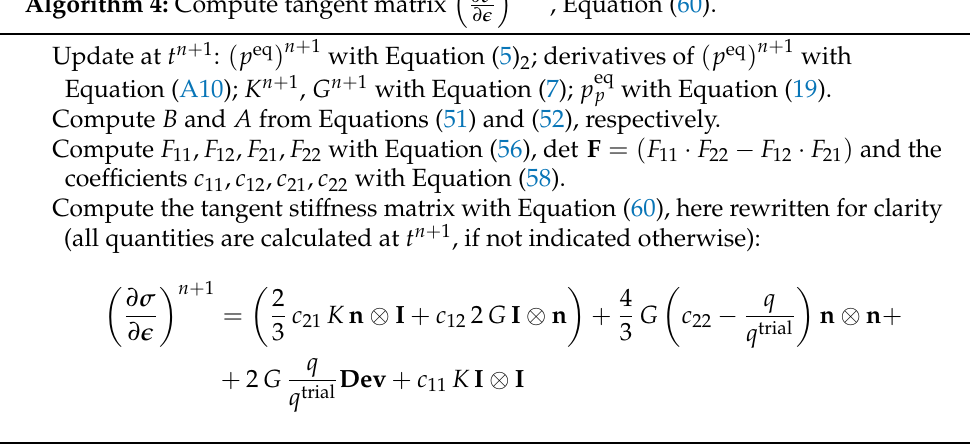
Algorithm 4: Compute tangent matrix